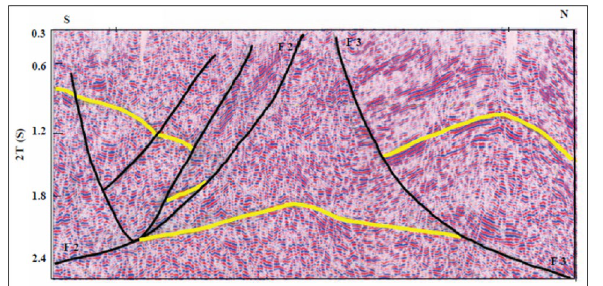
Fig. 11 Interpreted seismic profile along line H11(Chatterjee et al. 2006). The yellow line represents top of a producing horizon